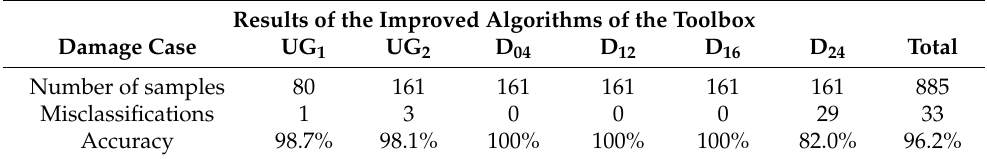
Table 5. Overview of the testing accuracy and number of misclassifications of the improved algo- rithms (BFC, RELIEFF with Pearson pre-selection, RFE-SVM) of the toolbox for GW-based SHM. Results of the Improved Algorithms of the